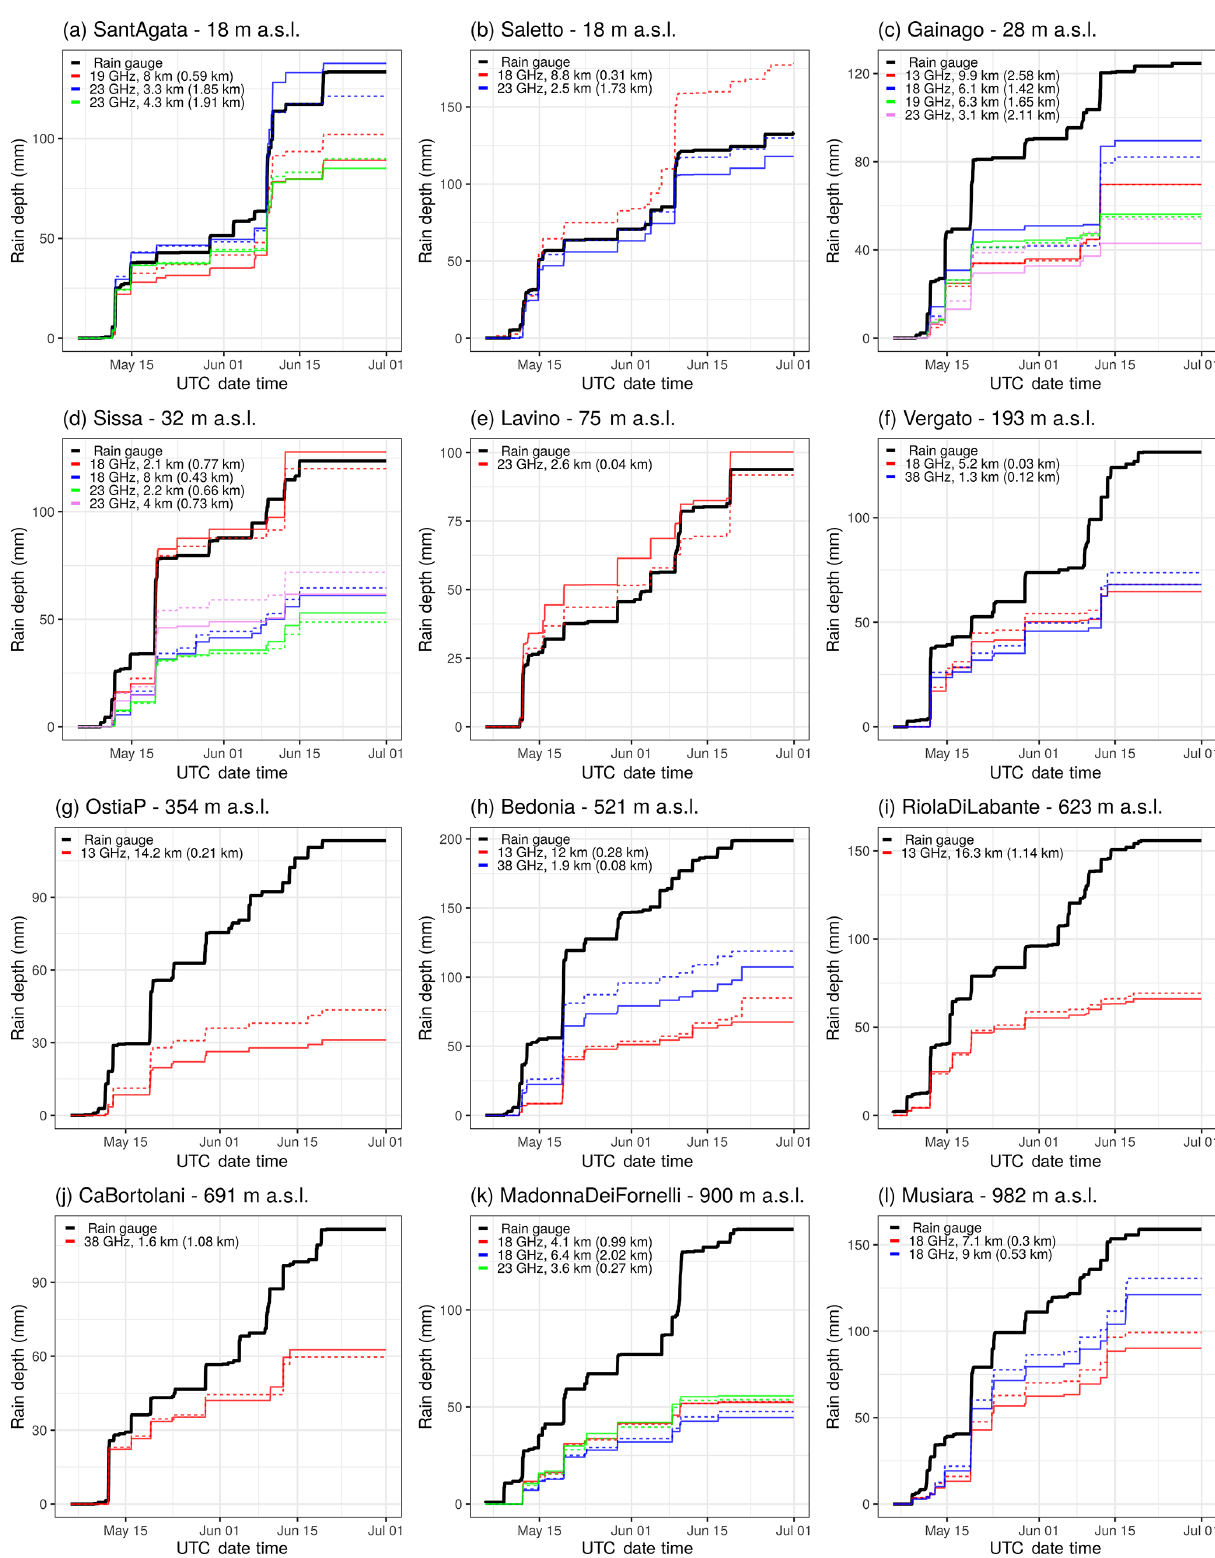
Figure 2. Accumulated rain depths over the entire period for the 26 CMLs selected for the single-link analysis. Each panel is named with the corresponding rain gauge, whose accumulated rain depth is shown by the thick black line. Solid and dashed lines represent the two directions (if both active) for every CML (distinguished by colour). Link length and link–rain gauge distance, in brackets, are also